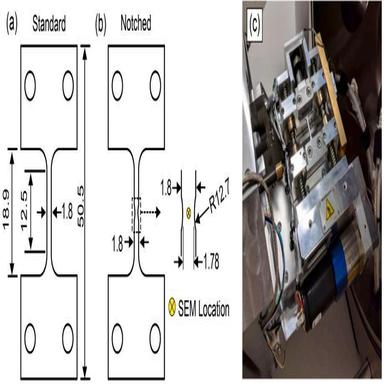
The (a) Standard and (b) Notched miniature in-situ dogbone specimen geometry. Dimensions are in mm. (c) MTI in-situ tensile stage.